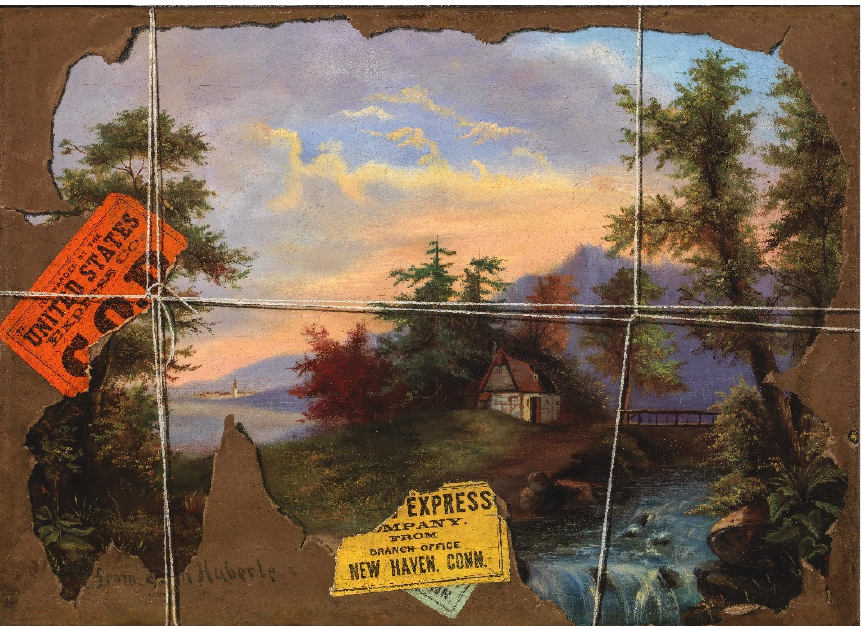
Figure 1. John Haberle, Torn in Transit , ca. 1890–1895, oil on canvas, 36.8 × 51.4 cm, Smithsonian American Art Museum, Gift of Sheila and Richard J. Schwartz, and museum purchase through the Luisita L. and Franz H. Denghausen Endowment, 2018.6.